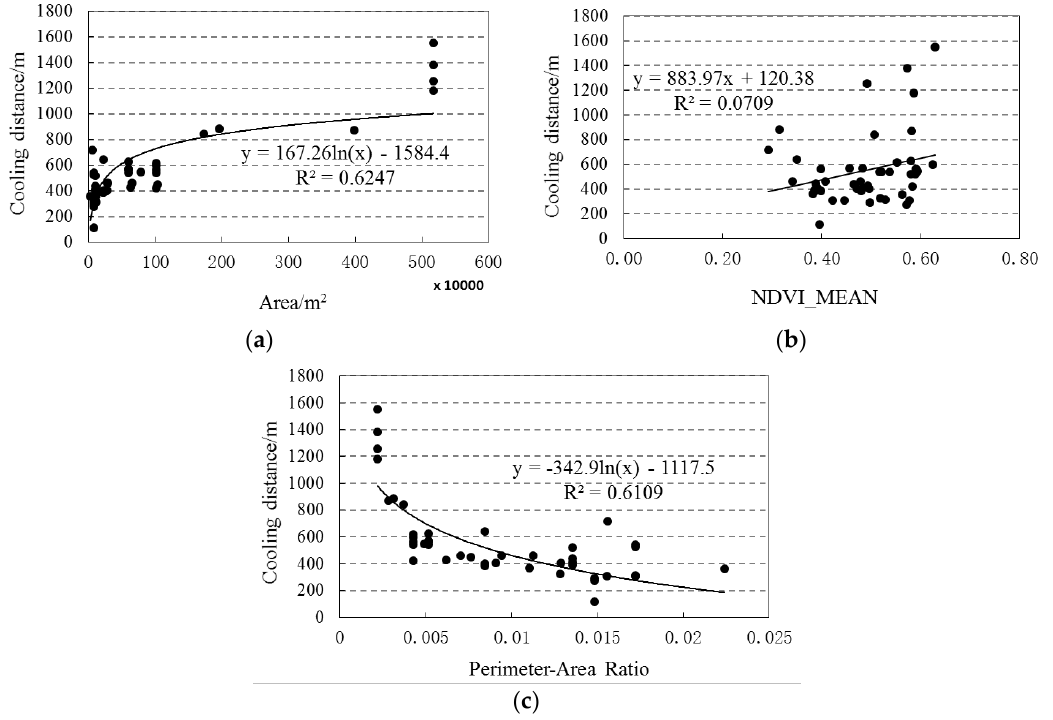
Figure 4. Relationships between urban green cooling distance, area, NDVI mean, and PARA. ( a ) represents the relationship between urban green space area and cooling distance in five time periods remote sensing image data; ( b ) represents the relationship between the mean NDVI of each urban green space and cooling distance in the same images; and ( c ) represents the relationship between shape index of each urban green space and the cooling distance in the same images.